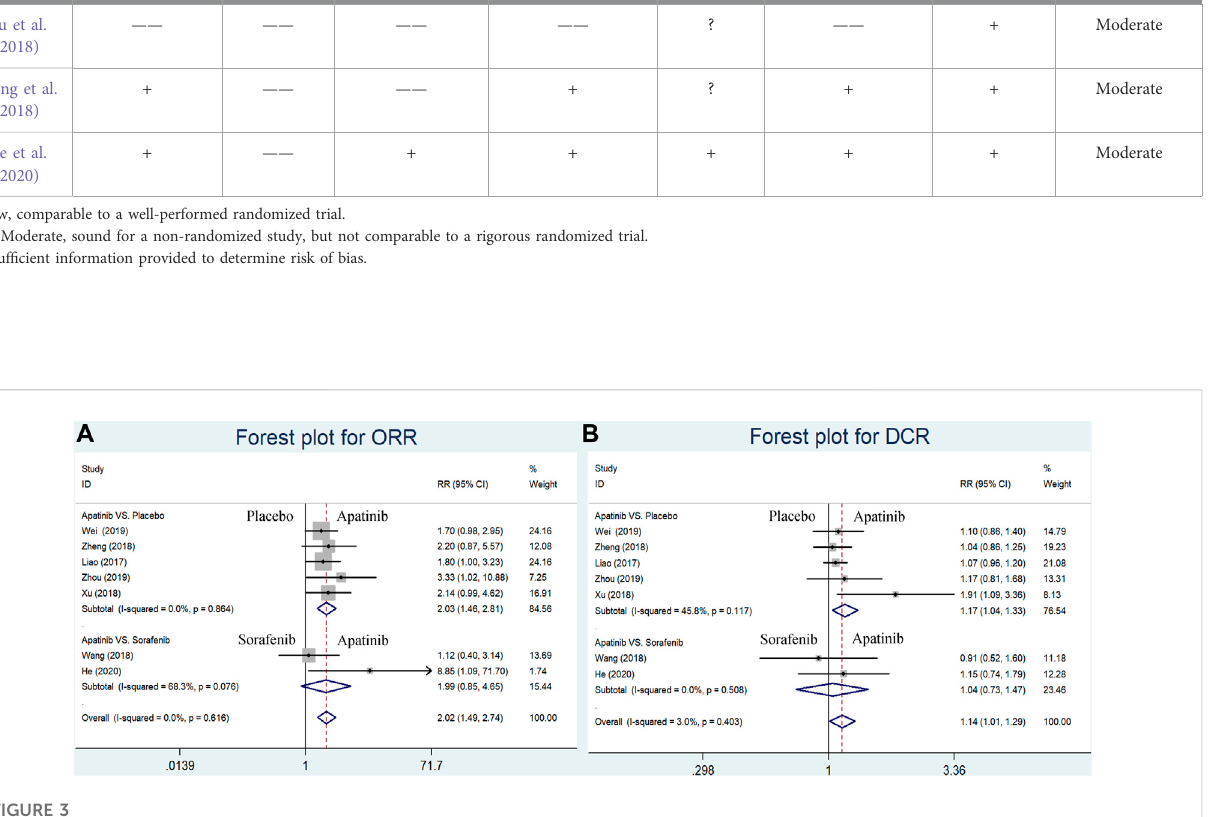
TABLE 4 Risk of bias of each domain and overall risk of bias in non-randomized studies (ROBINS-I). Author